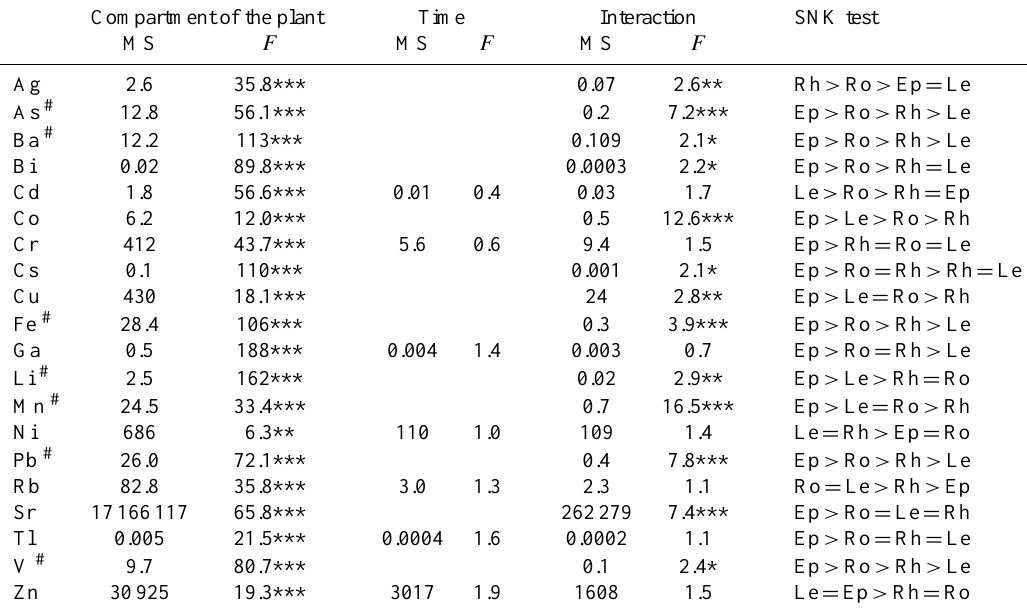
Table 2. Two-way factorial ANOVA on differences in trace element concentration of Posidonia oceanica among the factors, compartment of the plant (df = 3) and time (df = 5) and the interaction between them (df = 15). Le: leaves; Rh: rhizomes; Ro: roots; Ep: epibiota. Compartment of the plant Time Interaction SNK test